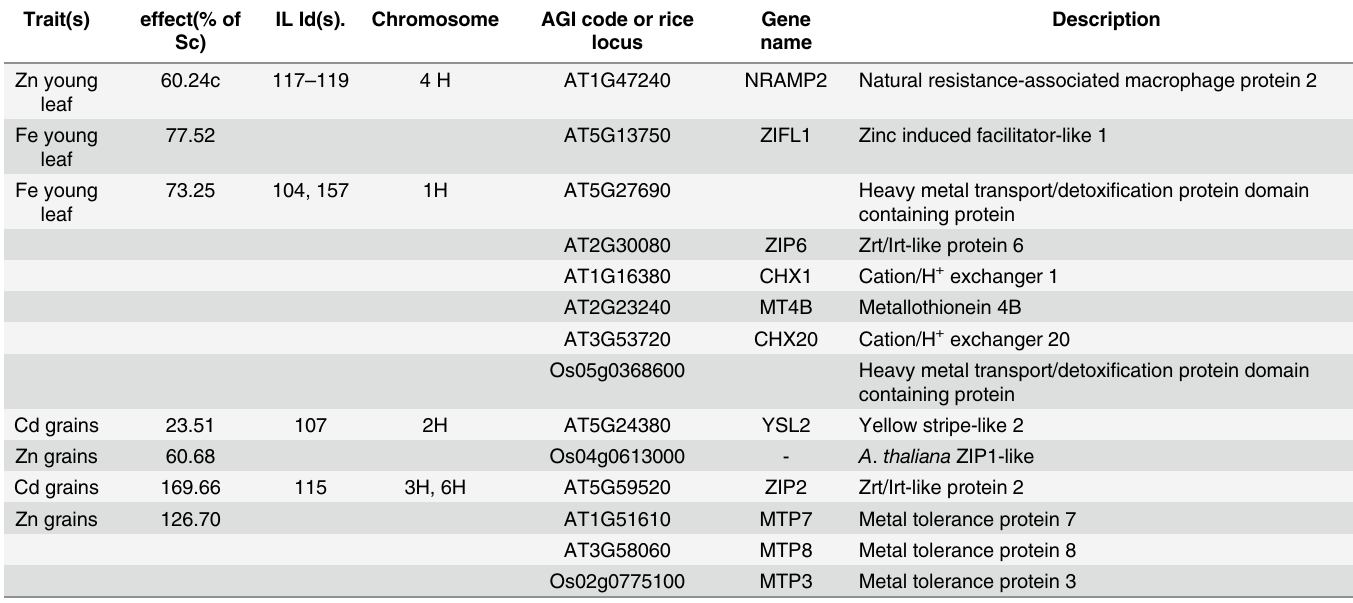
Shown are selected QTL with their effect strength (given as percentage of the concentration found in the parent genotype Scarlett) and candidate genes based on homology to Arabidopsis or rice found in the (overlapping/unique) introgressions of the indicated